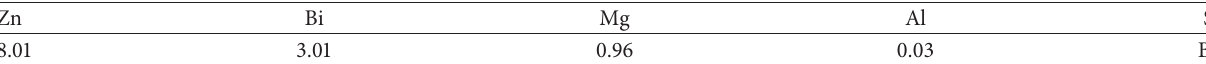
Table 2: The chemical composition of the Sn